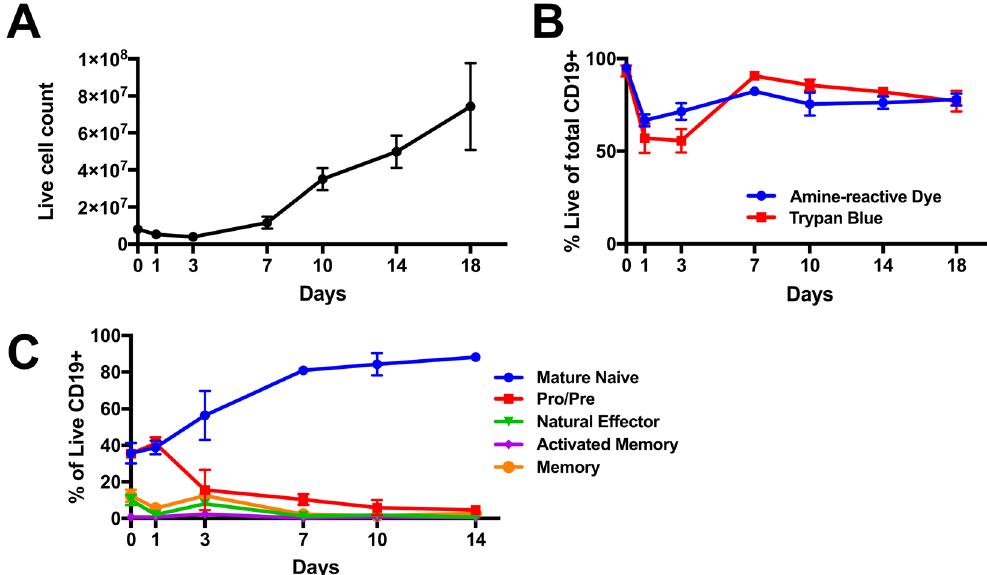
Figure 1. B cells are efficiently expanded with CD40L and IL4. Total cell numbers ( A ) and viability ( B ) of isolated B cells in culture and during expansion (n = 3). ( C ) Percentage of Naïve B cells (IgD + IgM + CD27 − , blue line ), Pro or Pre B cells (IgD + IgM − CD27 − , red line ), Natural Effector B cells (IgD + IgM + CD27 + , green line ), Memory B cells (IgD − CD27 + CXCR5 + , orange line ), and Activated Memory B cells (IgD − CD27 + CXCR5 − , purple line ) of total live CD19 + B cells in culture over time. (n =